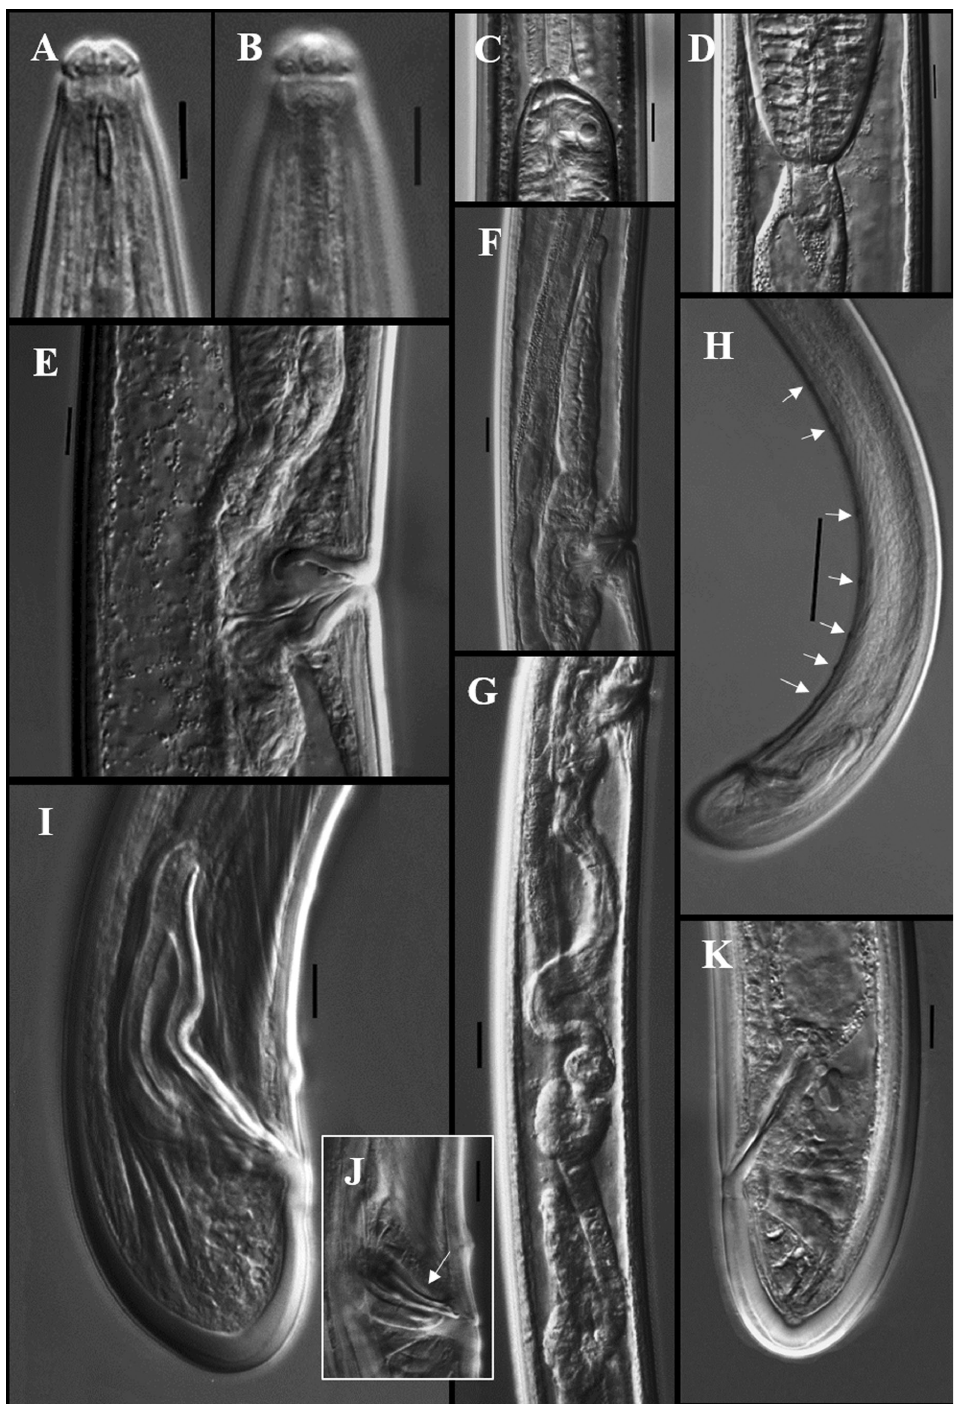
Fig. 12. Axonchium paracingulatum sp. nov. (LM photographs). A – G , K . Paratype 3, ♀ (slide 3). H – J . Paratype 2, ♂ (slide 2). A . Anterior region. B . Anterior end showing amphid. C . Junction between two parts of the pharynx. D . Cardia. E . Vulva and vagina. F – G . Female genital branches. H . Ventromedian supplements. I . Male posterior end. J . Arrow indicating lateral guiding piece and distal end of spicule. K . Female posterior end. Scale bars: A–E, I–K = 10 µm; F–G = 20 µm; H = 50